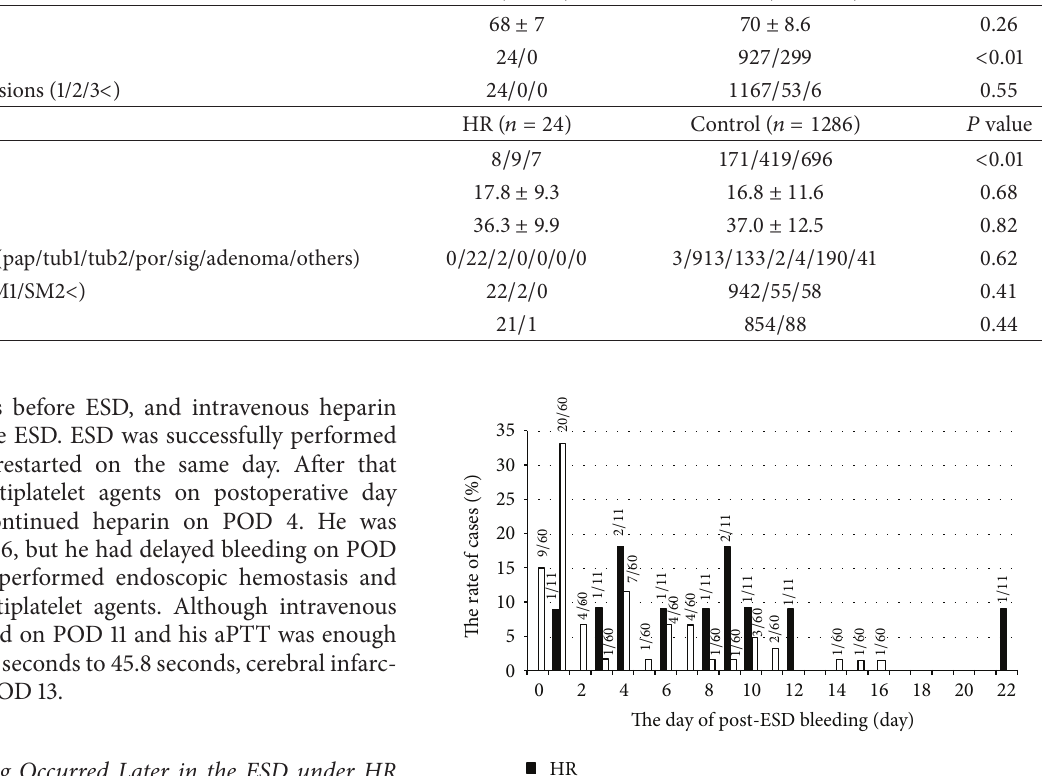
Table 3: Clinicopathological findings of patients and lesions treated with ESD with or without HR (control). Patients